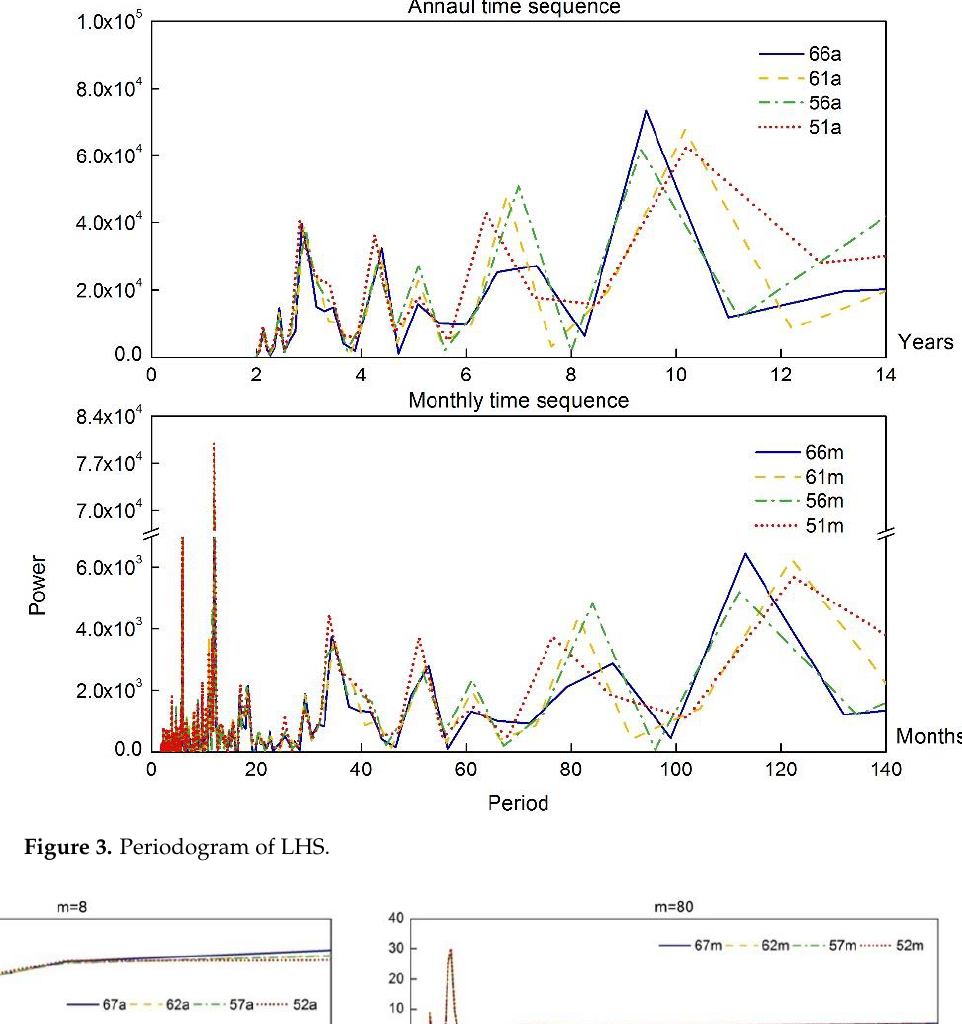
Figure 2. Periodogram of HHS.